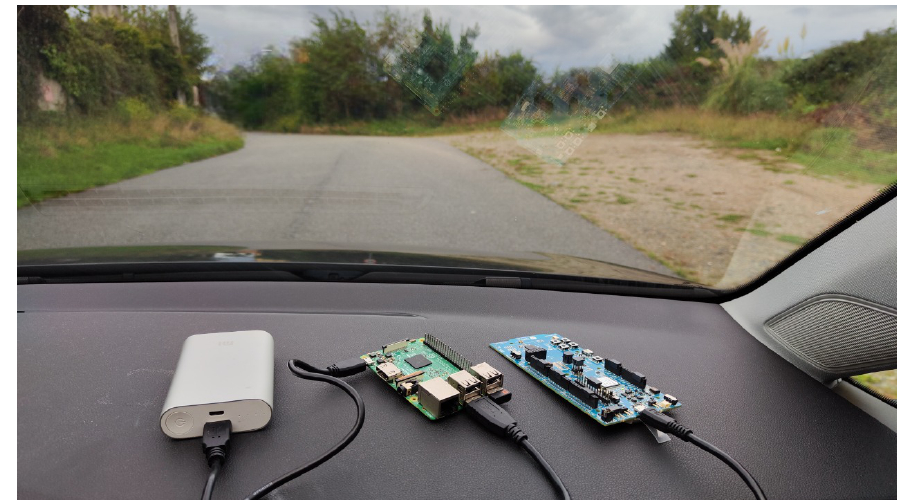
Figure 3. IoT node inside the vehicle in the test